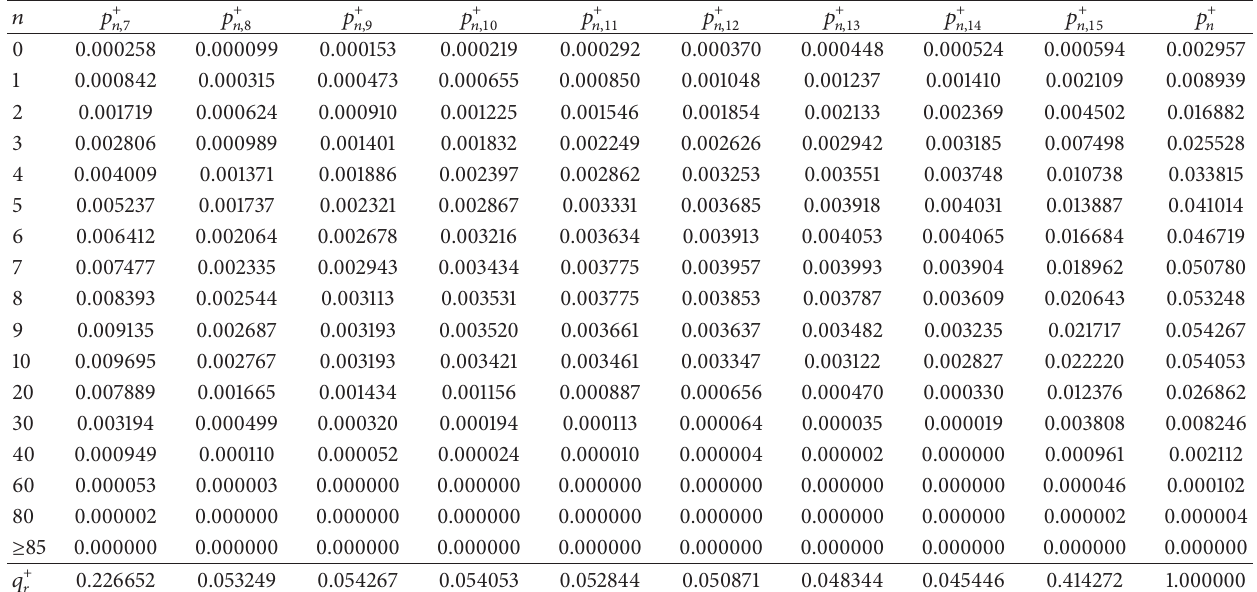
Table 3: Joint distribution of queue and server content at departure epoch ( 𝑝 + 𝑛,𝑟 ) of an 𝑀/𝐺 (7,15) 𝑛 /1 queue with 𝐺 ∼ 𝐸 4 , 𝜆 = 80 , 𝜇 = 0.75 , 𝜇